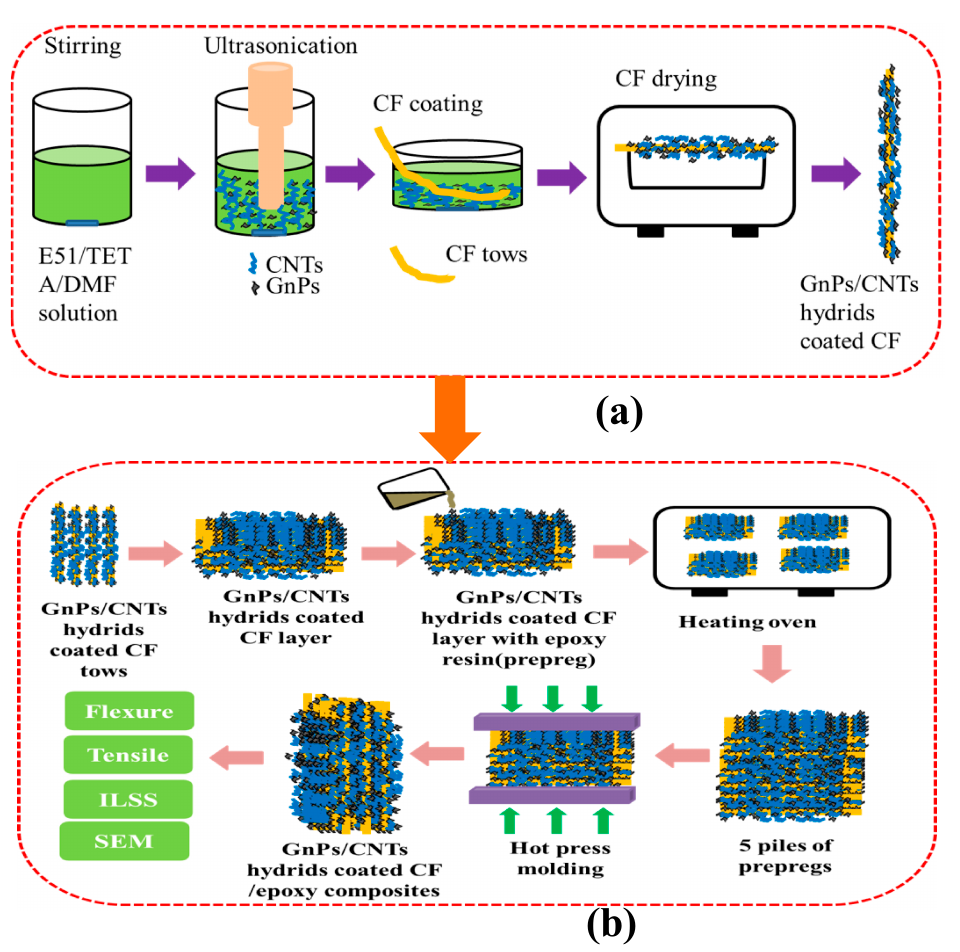
Figure 1. ( a ) the schematic of graphene nanoplates (GnPs) / carbon nanotubes (CNTs) hybrid coated carbon fiber (CF) and ( b ) the manufactured of the carbon fiber composites laminate.